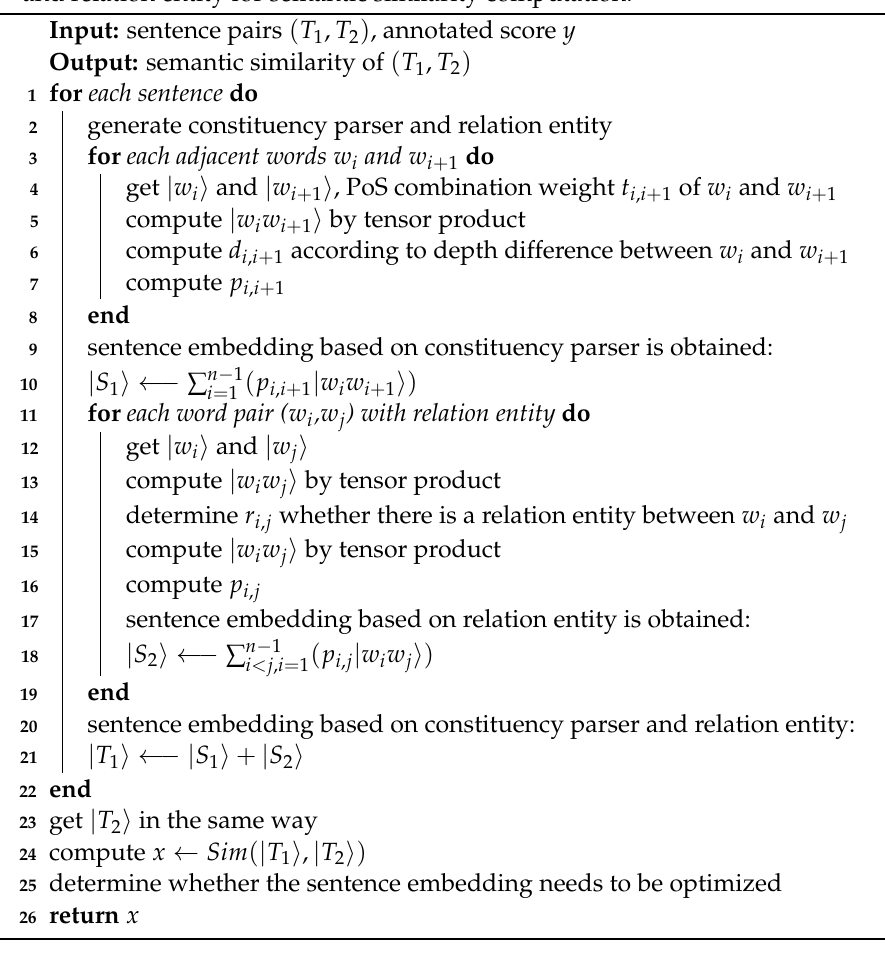
Algorithm 1: Framework of sentence embedding based on constituency parser and relation entity for semantic similarity